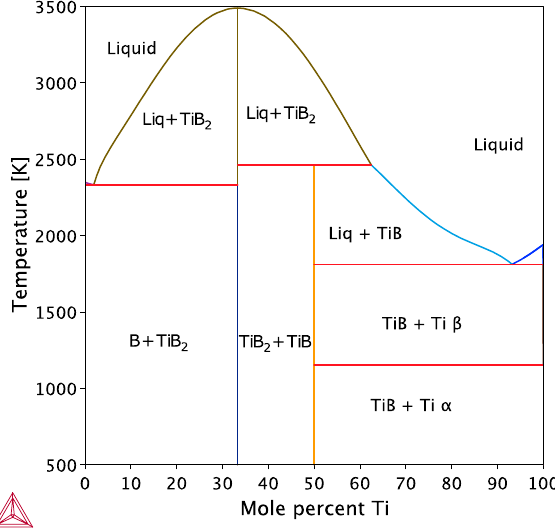
Figure 2. Simulated B—Ti phase diagram showing that Ti and TiB are the stable phases for 10 wt.% B (~77 at.% Ti).